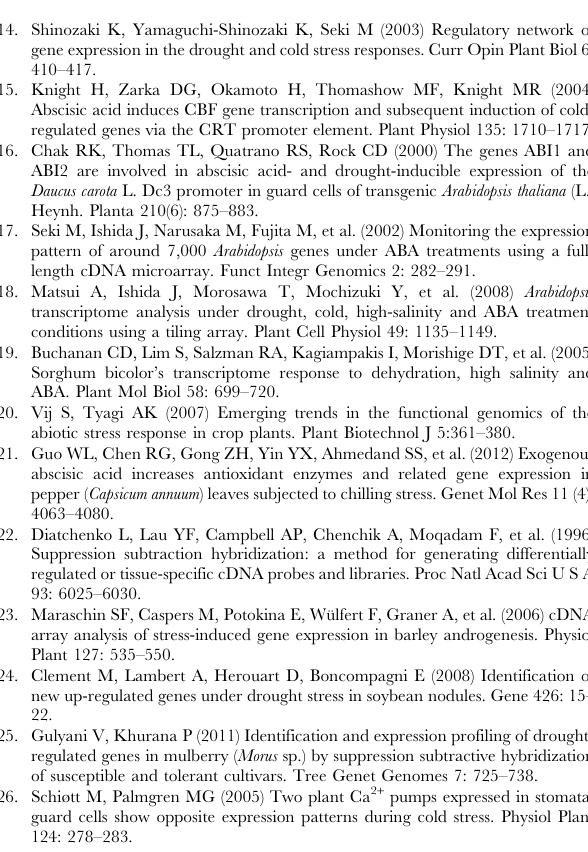
Figure S2 Total RNA of leaves in pepper seedlings.